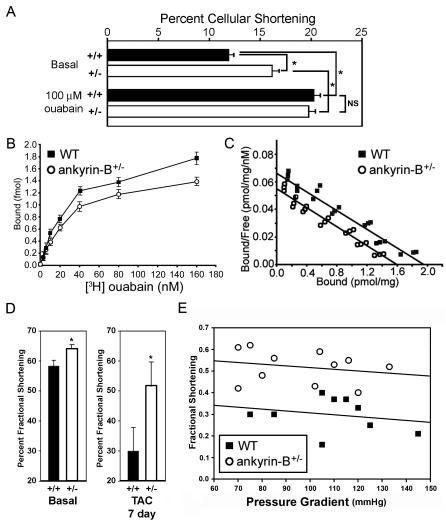
Loss of ankyrin-B-dependent [3H]-ouabain-binding sites mimics the cellular action of digitalis.(A) Isolated unloaded ankyrin-B+/− ventricular cardiomyocytes display increased cellular shortening compared to unloaded WT cardiomyocytes, consistent with increased [Ca2+]i transients [14]. Asterisk represents p<0.01 between untreated WT and ankyrin-B+/− cardiomyocytes (15–20 cardiomyocytes from 4–5 mice). WT and ankyrin-B+/− cardiomyocytes treated with maximal doses of ouabain (100 µM) display significant elevations in cellular shortening compared with untreated WT and ankyrin-B+/− cardiomyocytes (15–20 cardiomyocytes from 4–5 mice, p<0.01, asterisks). (B–C) Live, isolated ankyrin-B+/− cardiomyocytes display reduced (∼20%) surface expression as measured by binding of [3H]-ouabain (n = 3, p<0.01). (D–E) Conscious echocardiograms of wild-type and ankyrin-B+/− mice before and after transverse aortic constriction. Black labels represent wild-type animals, white labels represent ankyrin-B+/− data. Ankyrin-B+/− mice show preserved fractional shortening compared to wild-type mice over a wide range of hemodynamic stress (induced through transverse aortic constriction).